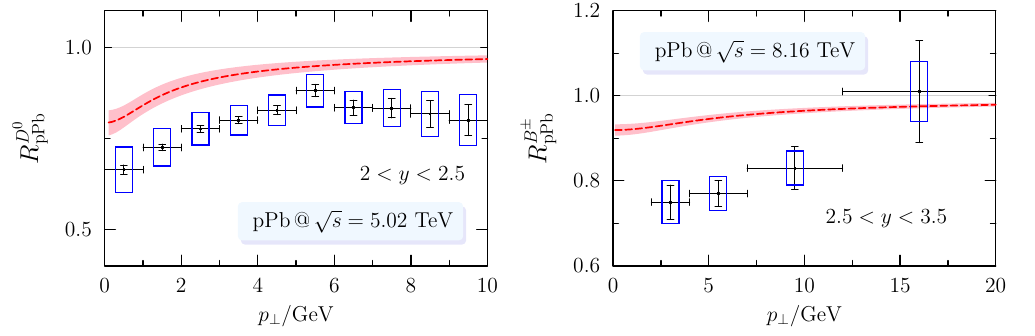
Figure 3 . Comparison between LHCb data [48, 49] and FCEL baseline predictions of the p √ dependence of R pPb , for D 0 production at s = 5 . 02 TeV in the rapidity interval 2 < y < 2 . 5 (left), √ and for B ± production at s = 8 . 16 TeV in the interval 2 . 5 < y < 3 . 5 (right). √ suppression in pPb collisions at s = 8 . 16 TeV [49], a similar plot for B ± production is provided in figure 3 (right), over a larger rapidity window ( 2 . 5 < y < 3 . 5 ) and for p ≤ 20 ⊥